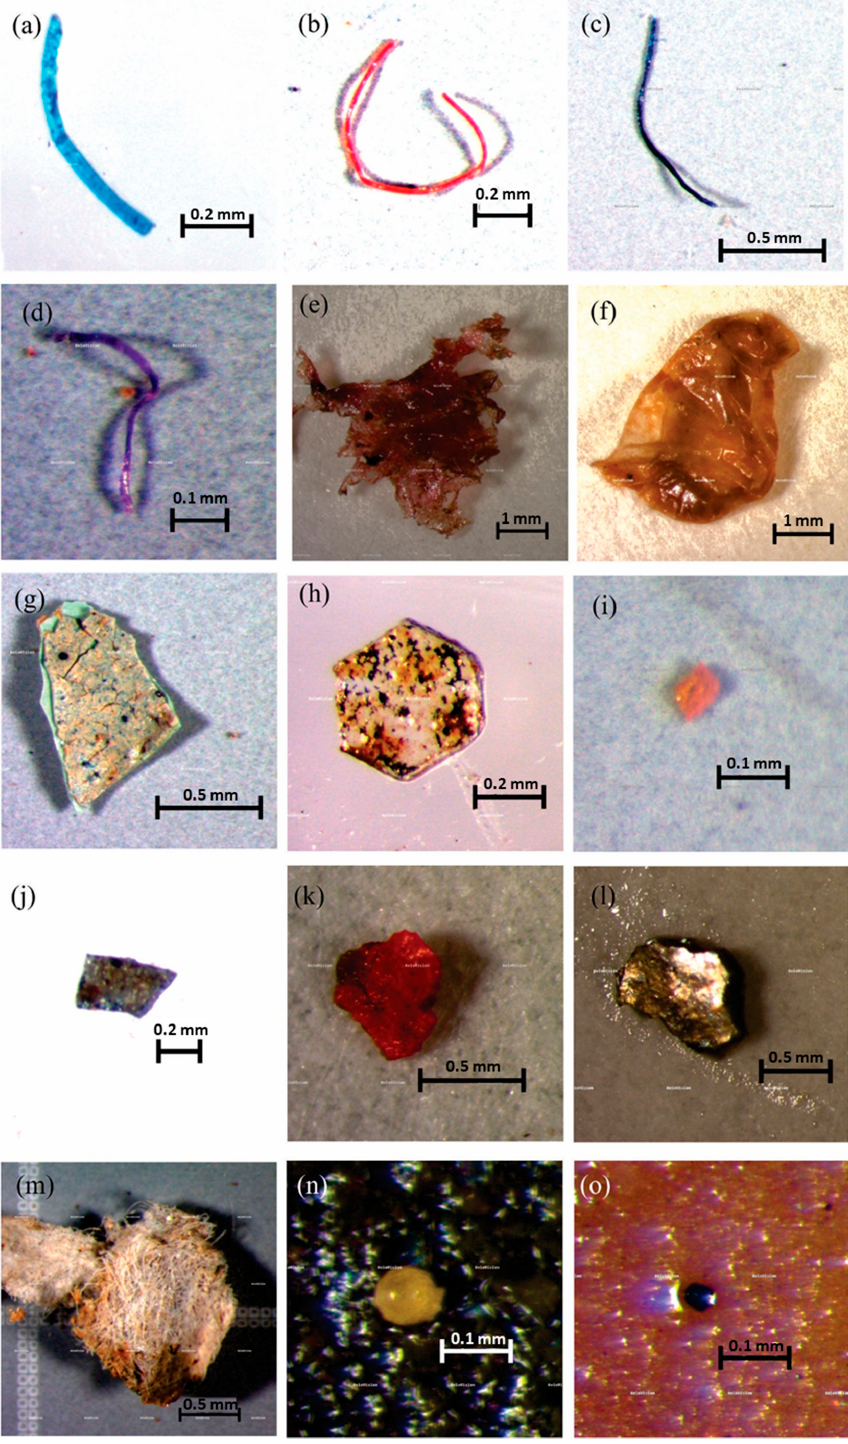
Figure 4. Types of MPs found in sediments from the SDR: ( a – d ) lines / fibres; ( e – h ) films and sheets, ( i – m ) fragments; and ( n , o )